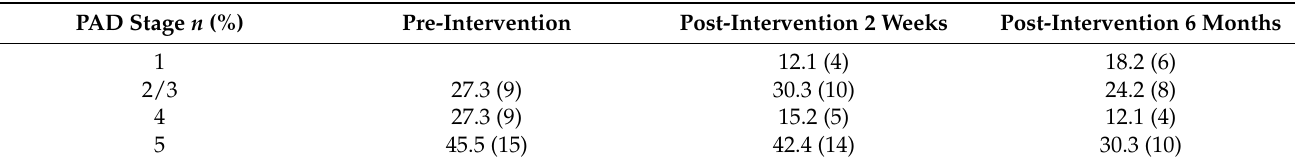
Table 3. Peripheral arterial disease (PAD) stages; PAD classification according to Rutherford pre- and